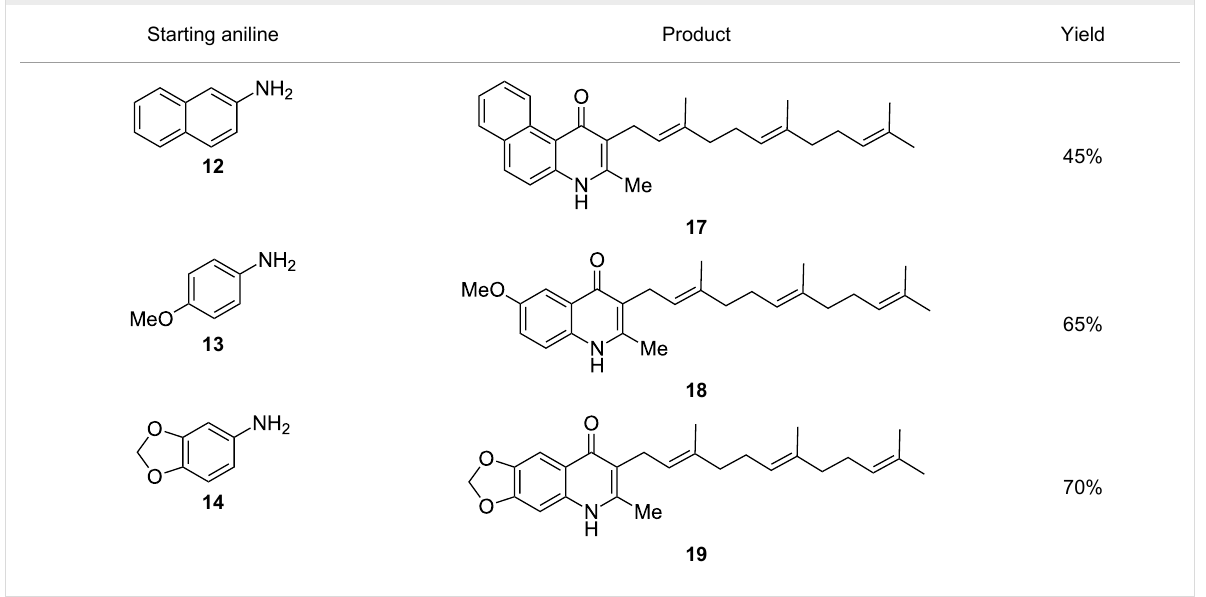
Table 1: Synthesis of aurachin D analogues with aromatic variations.